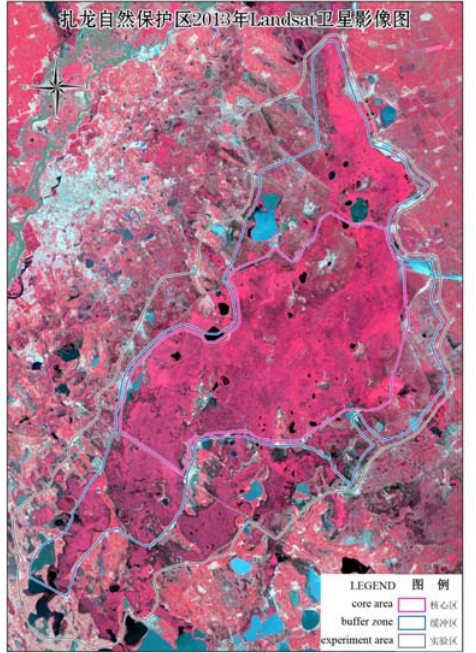
Figure 1. Landsat image of Zhalong wetland nature reserve in